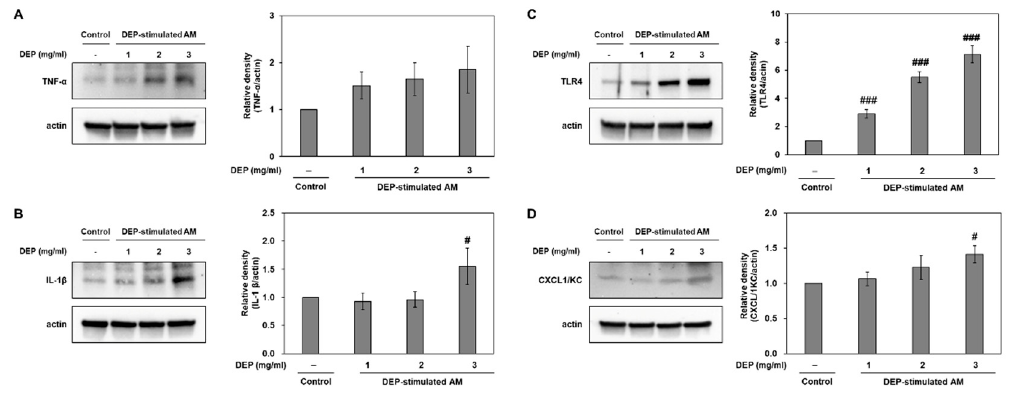
Figure 7. Representative Western blots and relative densities of ( A ) TNF- α , ( B ) IL-1 β , ( C ) TLR4, and ( D ) CXCL1/KC in DEP-stimulated AM. AM were stimulated with DEP 1, 2, or 3 mg mL − 1 . Western blotting was performed 3 h after DEP stimulation. Data are means ± SD ( n = 3 per group). # p < 0.05 or ### p < 0.001 vs. control.